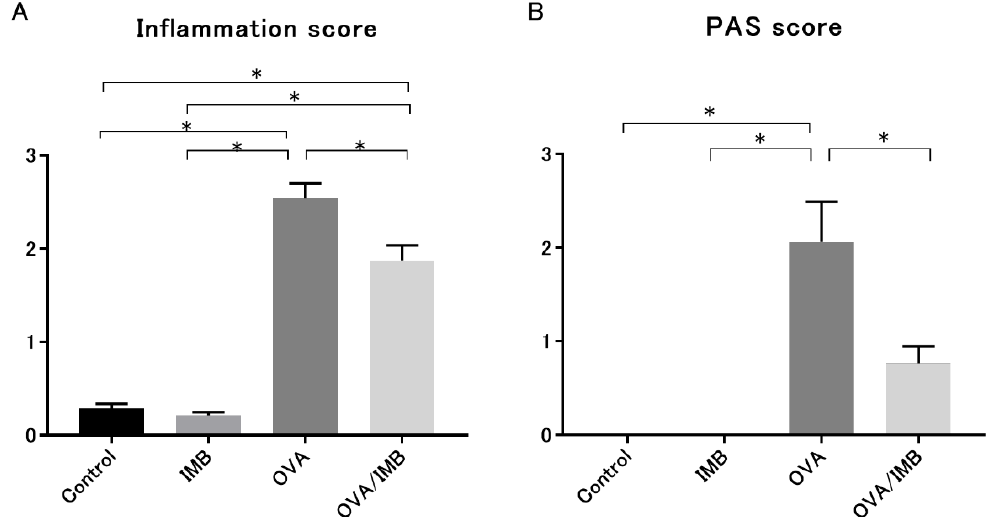
Figure 7. Representative images of lung tissues by PAS staining from each group are shown at 200× magnification. Scale bar = 100 µm.